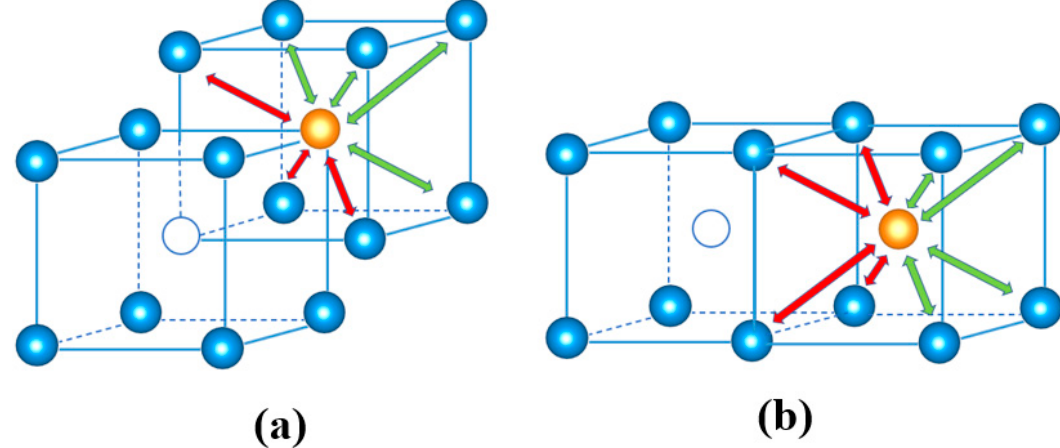
Figure 9. Schematic diagram of bonds breaking when forming the ( a ) 1NN and ( b ) 2NN divacancy. The white circle, blue sphere, and orange sphere denote the pre-existing monovacancy, bulk W atom, and second W atom to be removed, respectively. The green double-sided arrow represents the normal W-W bond, while the red one refers to the enhanced 1NN–2NN bond.